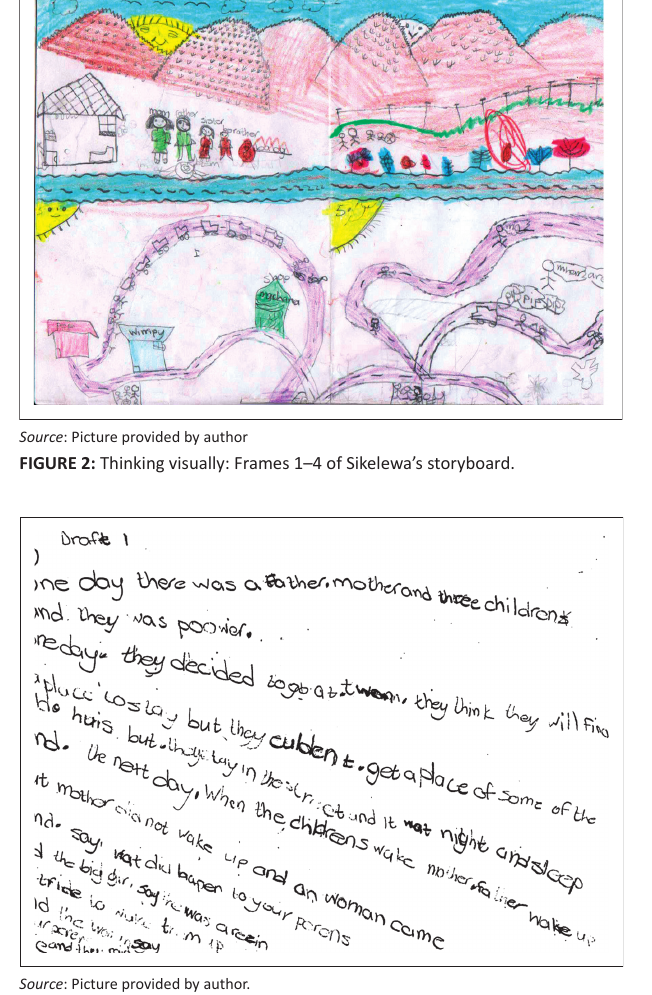
FIGURE 3: Sikelelwa’s first